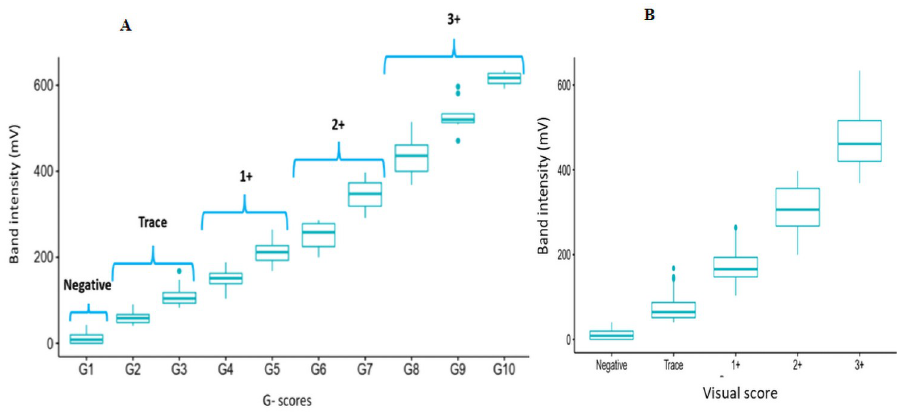
Fig 4. Correlation between infection intensity from the POC-CCA tests using the ESEquant reader and the G- scores (Fig 4A) or their corresponding visual score (Fig